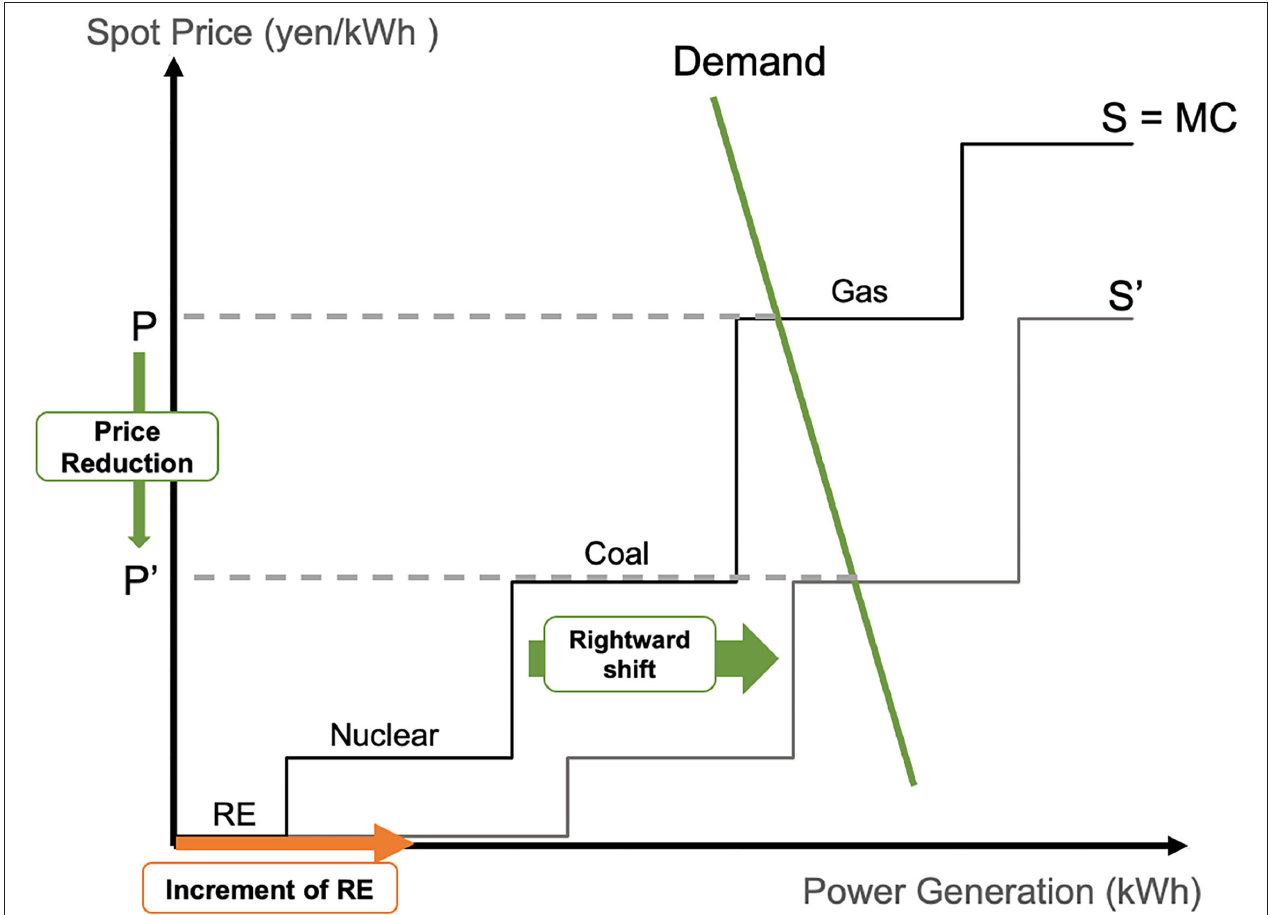
FIGURE 1 | Conceptional graph of the merit order effect (MOE). (Source: created by